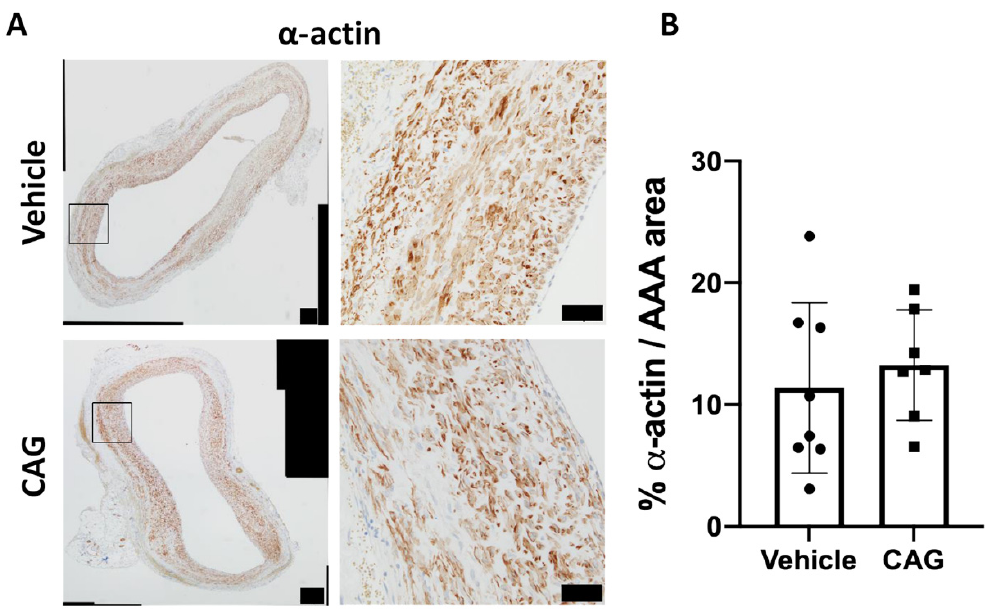
Figure 9. CAG does not affect α -actin positive area in the aneurysm wall. ( A ) Representative micrographs of α -actin staining from vehicle and CAG AAAs at day 28 (enlargement represent black square on the left image, (n = 8/7). Scale bar (black box) in micrographs to the left: 100 µ m and in micrographs to the right: 50 µ m. ( B ) Semi-quantification of α -actin positive area of total AAA area. Values are mean ± SD.